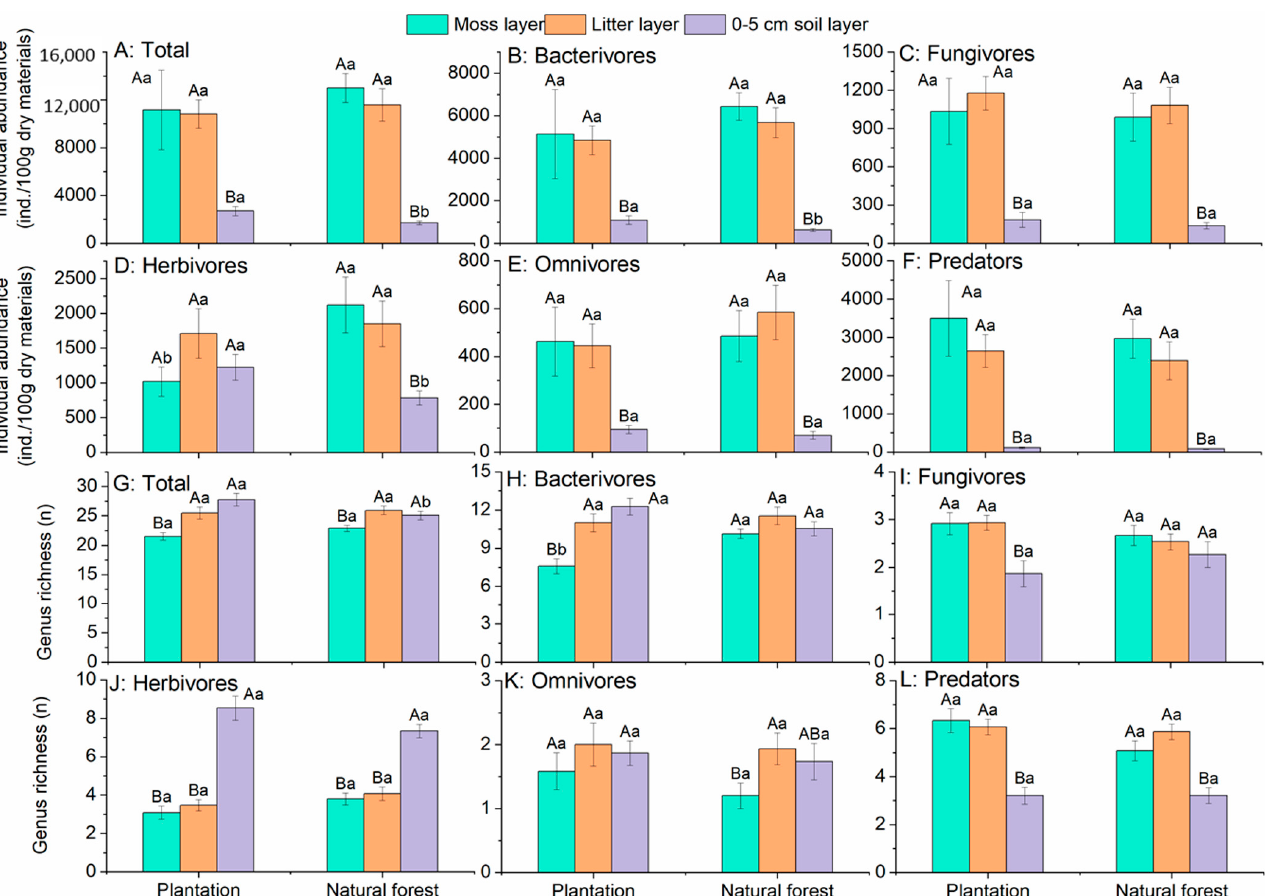
Figure 2. Non-metric multi-dimensional scaling (NMDS) based on Bray – Curtis similarity for the nematode community composition in subalpine spruce plantations and natural forests. PM: planta- tion moss layer; PL: plantation litter layer; PS: plantation soil layer; NM: natural forest moss layer; NL: natural forest litter layer; NS: natural forest soil layer. *: interaction of forest type and layer. ***: p < 0.001; ns: p > 0.05.